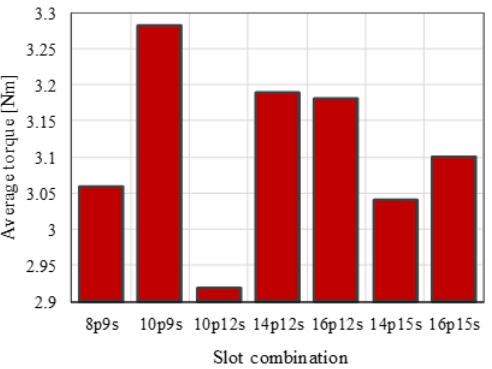
Figure 10. Generated torque with respect to pole – slot combinations. Table 4. Winding factor for each number of poles and slots in concentrated